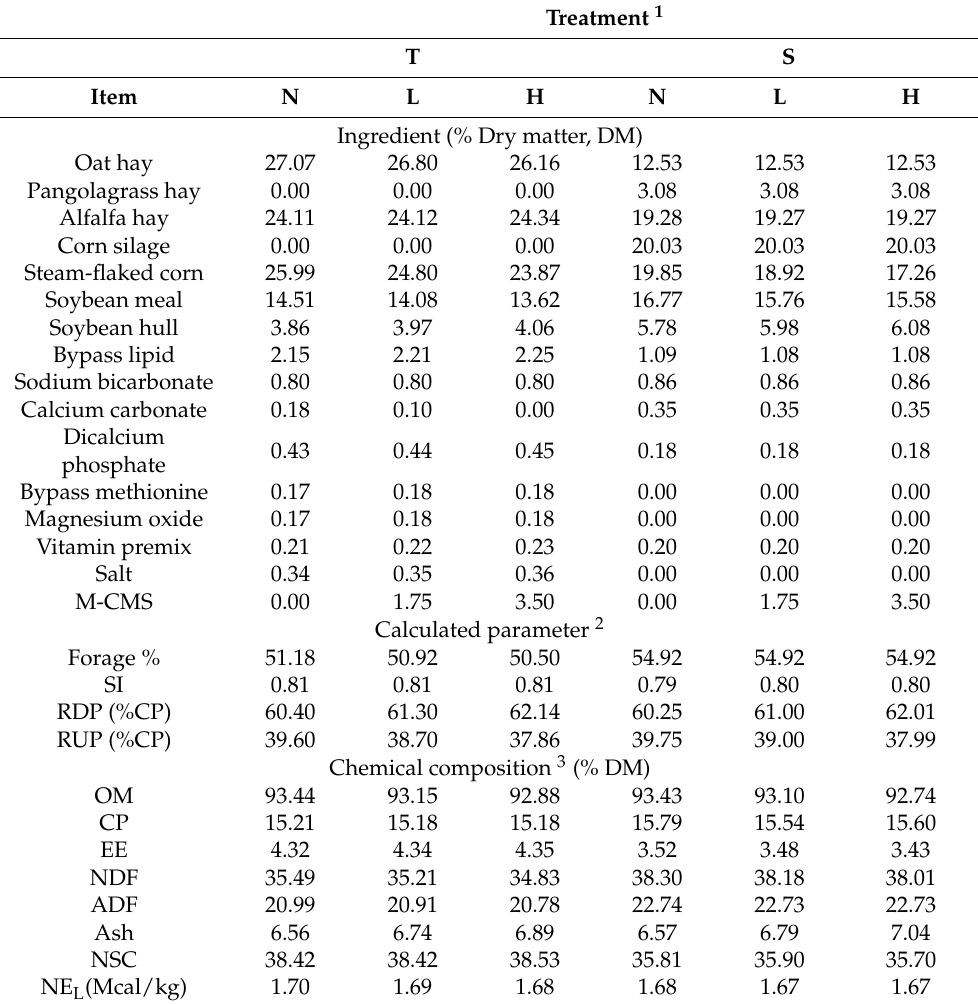
Table 1. Composition of diets for Experiment 1 (M-CMS supplementation to diets with or without corn